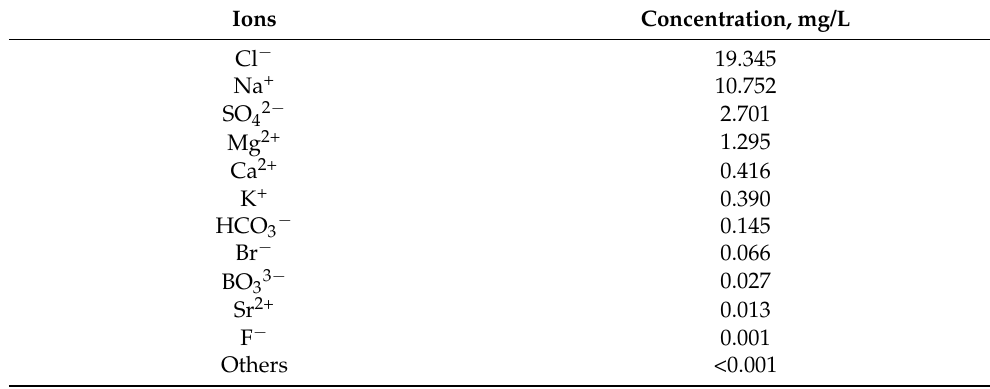
Table 1. Ions and concentrations in seawater